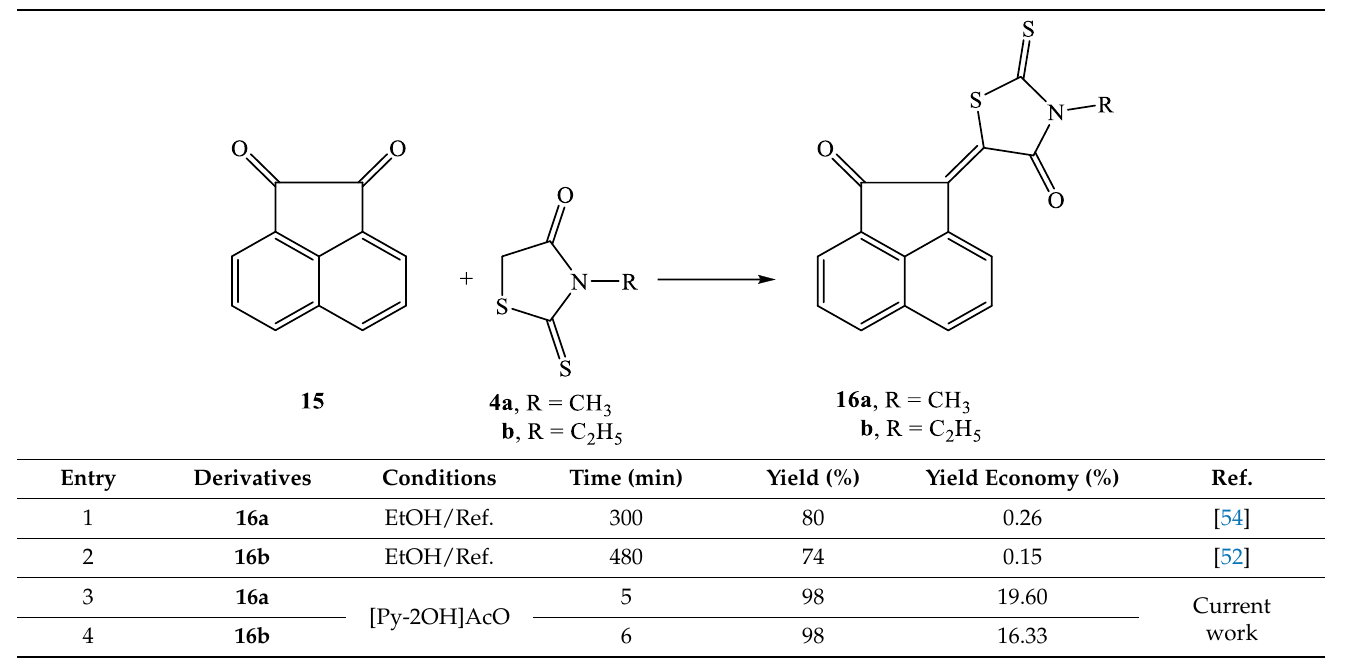
Table 3. Knoevenagel condensation of acenaphthylene-1,2-dione with rhodanines under different conditions.